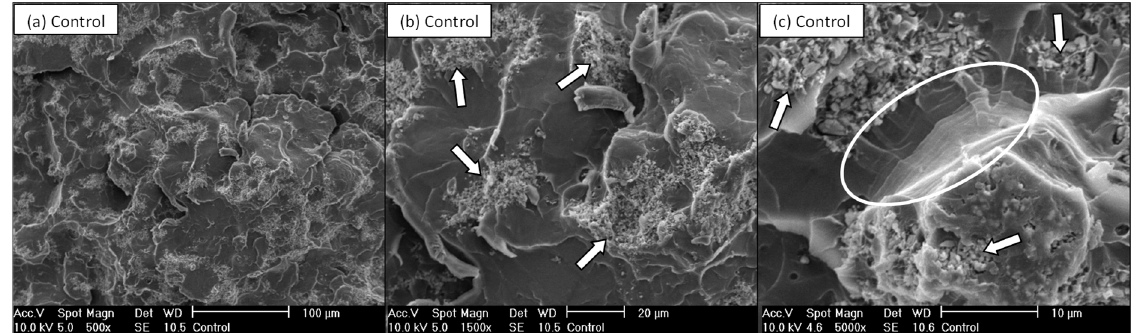
Figure 5. SEM micrographs of the Control bone cement fracture surfaces at 500× ( a ), 1500× ( b ) and 5000× ( c ) magnifications.